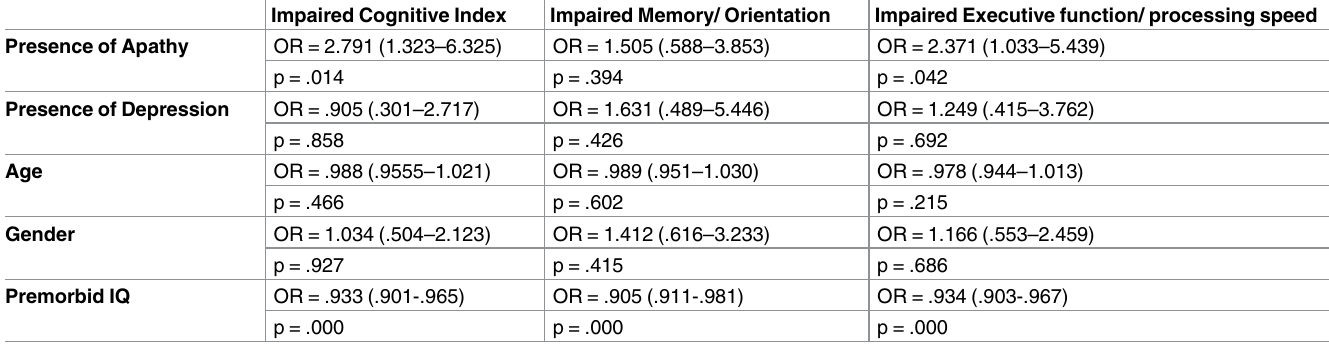
Table 2. Binary logistic regression